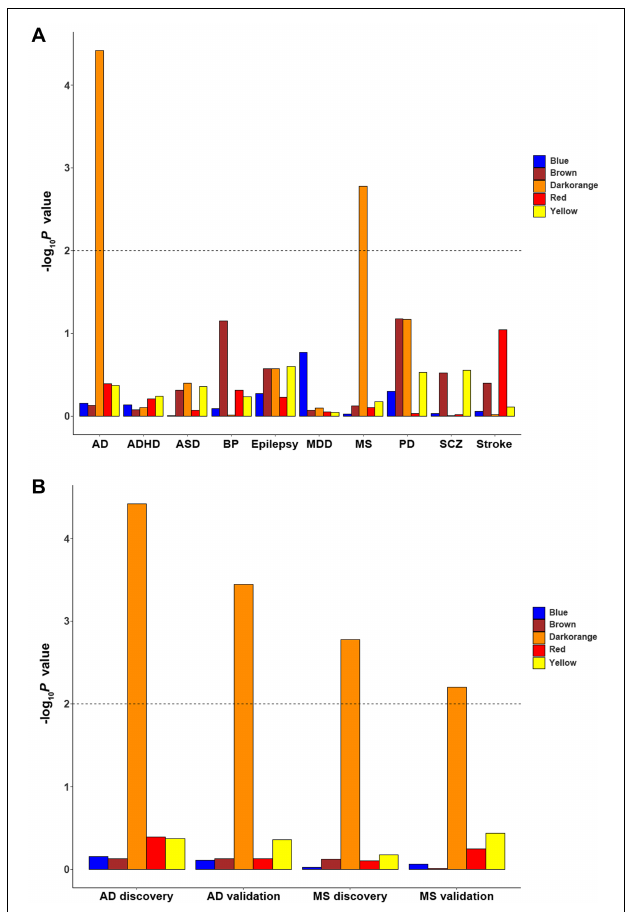
FIGURE 6 | The enrichment of cell-type-specific modules in ten common brain disorders. (A) The significant finding is that the microglial module is significantly enriched for MS and AD. (B) The discovery and replication enrichment for MS and AD. The dashed line indicates the Bonferroni-corrected threshold for 5 cell-type-specific modules. AD, Alzheimer’s disease; ADHD, attention deficit hyperactivity disorder; ASD, autism spectrum disorders; BP, bipolar disorder; EP, epilepsy; MDD, major depressive disorder; MS, multiple sclerosis; SCZ, schizophrenia; PD, Parkinson’s